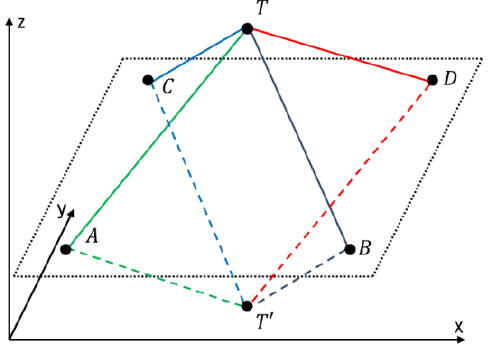
Figure 2. Flip ambiguity in 3D multilateration